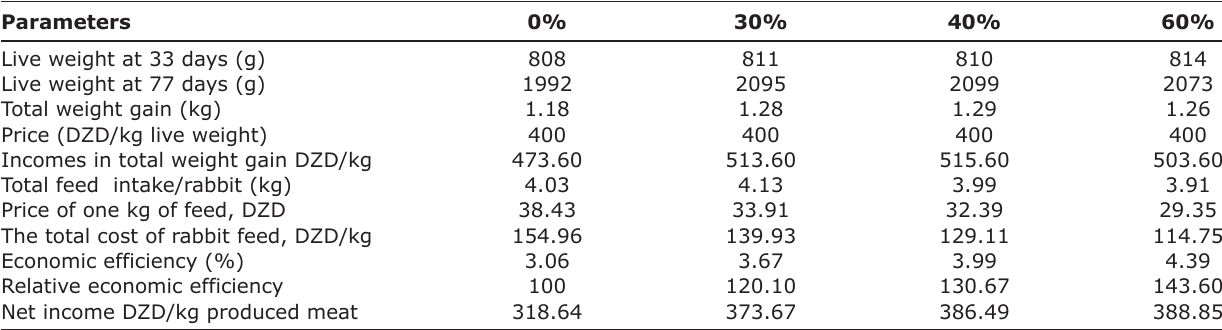
Table-7: Economic efficiency of replacing soybean meal with DAKM and alfalfa with DTP in fattening rabbits.